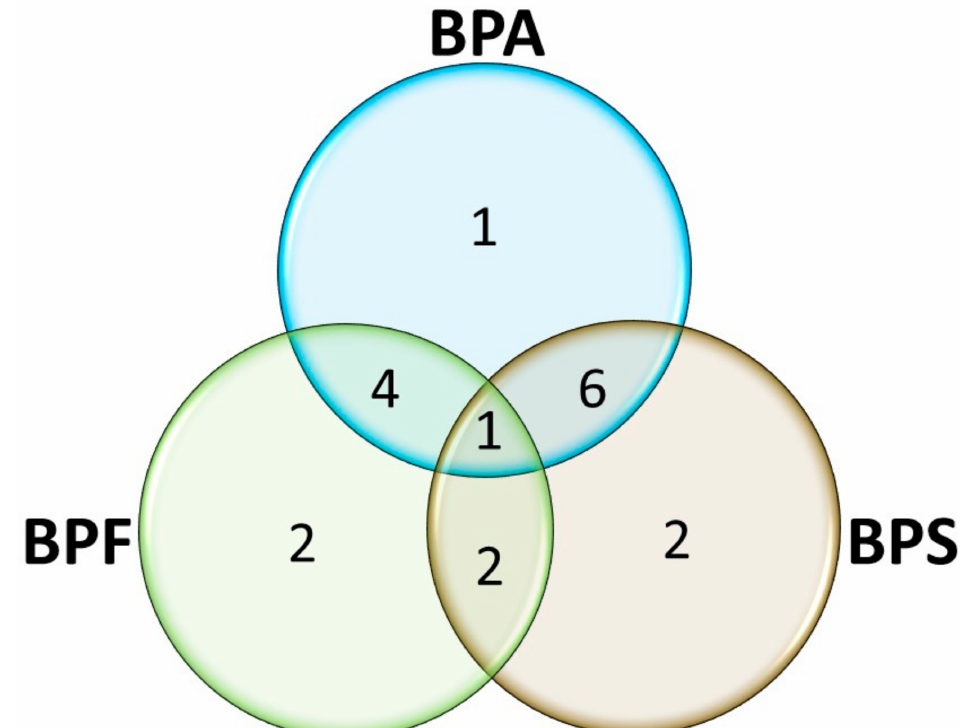
Figure 5. Venn diagram of pathways significantly perturbated by the different exposure groups (BPA, BPF, and BPS). The threshold for the significance level was p ≤ 0.05. Shared perturbated pathways: All bisphenols (1), BPA and BPS (6), BPA and BPF (4), BPF and BPS (2), unique to BPA (1), unique to BPF (2), and unique to BPS (2). Details regarding the specific pathways which were disrupted are listed in Table 1 and Supplementary Materials Table